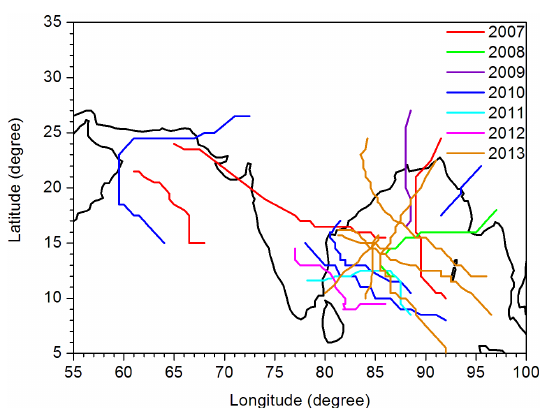
Figure 1. TC tracks with a minimum TC lifetime of 4 days and